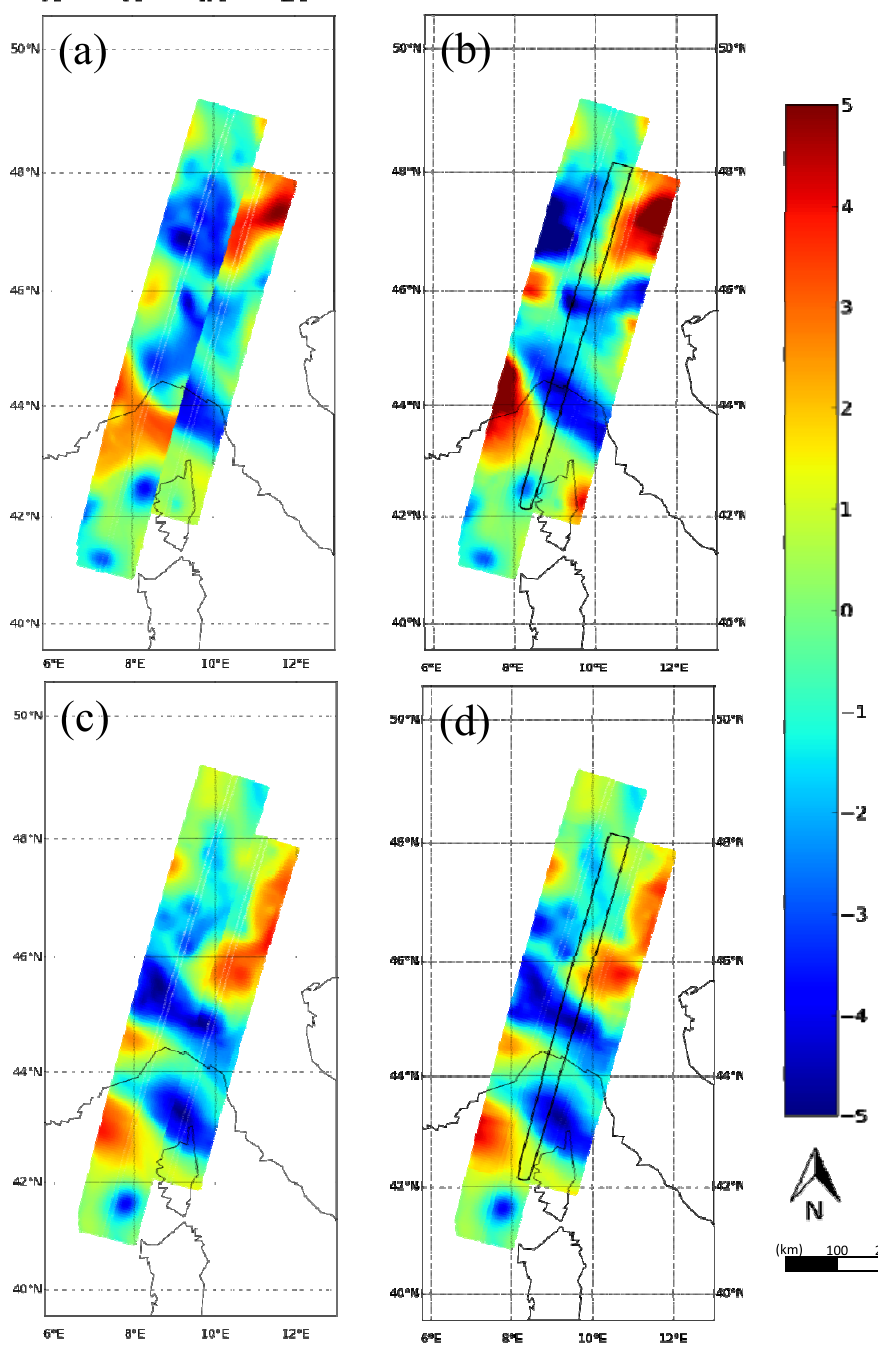
Figure 8. Spectral leakage of oceanic variability on roll with the sub-cycle method. ( a ) shows the “true” and roll-free topography for two overlapping images separated by a 10-day sub-cycle. If the oceanic variability is not accounted for in the roll inversion, both images are skewed by unweighted least squares to minimize the differences in the overlap zones, thus creating an artificially seamless composite ( b ). The same phenomenon is observed, albeit with a much smaller amplitude, if the proposed SWOT mission would use an orbit with a one-day sub-cycle (the small discontinuities from the two swaths of ( c ) disappear entirely in ( d )). Unit: